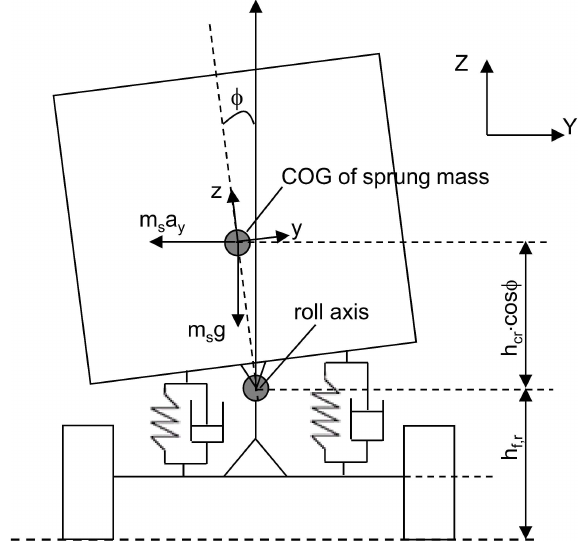
Figure 3. Schematic of the vehicle roll